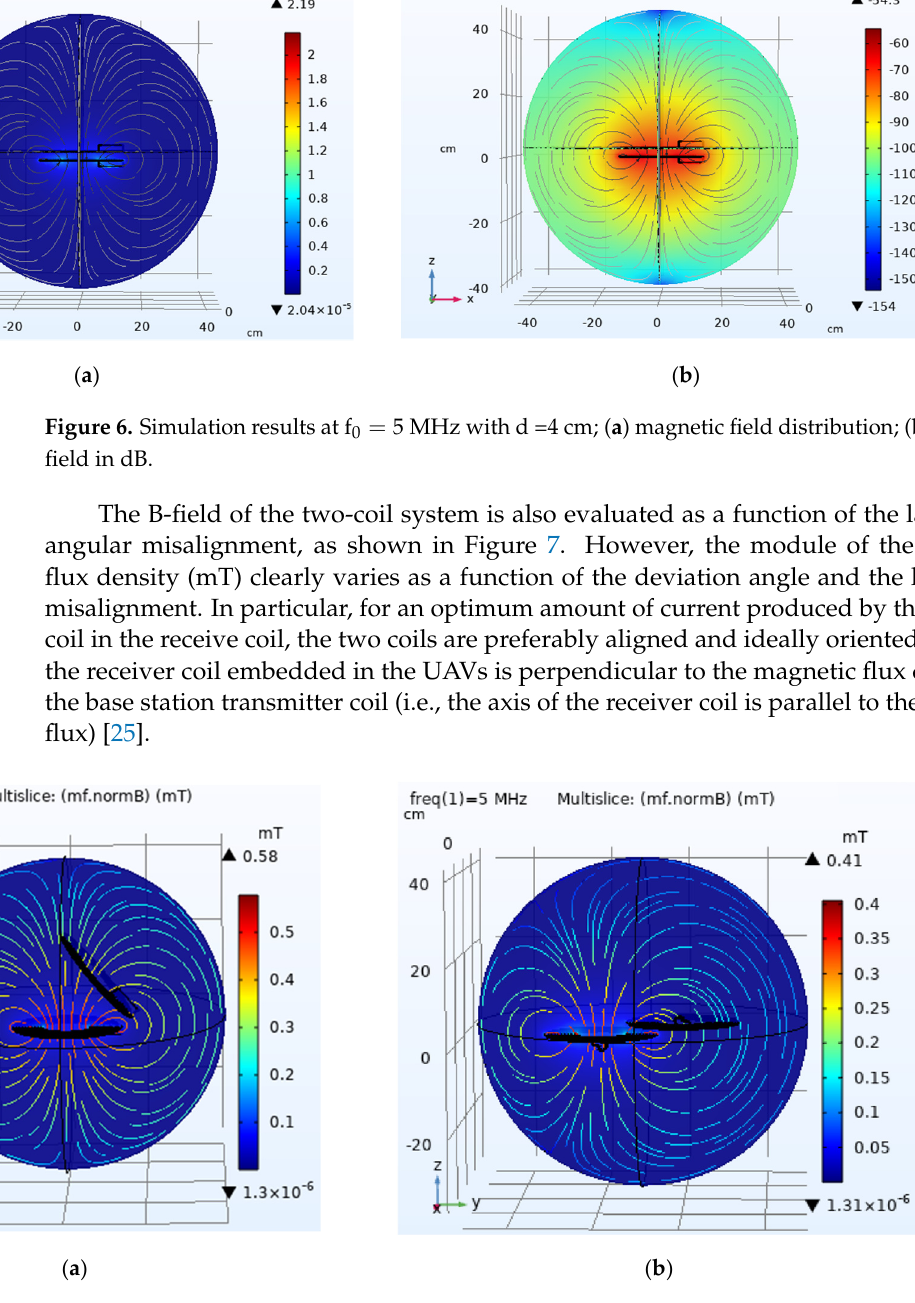
Figure 7. Magnetic field simulation results: ( a ) angular misalignment; ( b ) lateral misalignment; f (cid:2868) = 5 MHz .